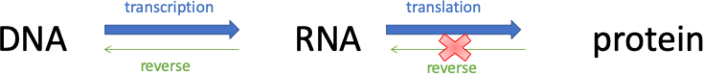
The central dogma of molecular biology.